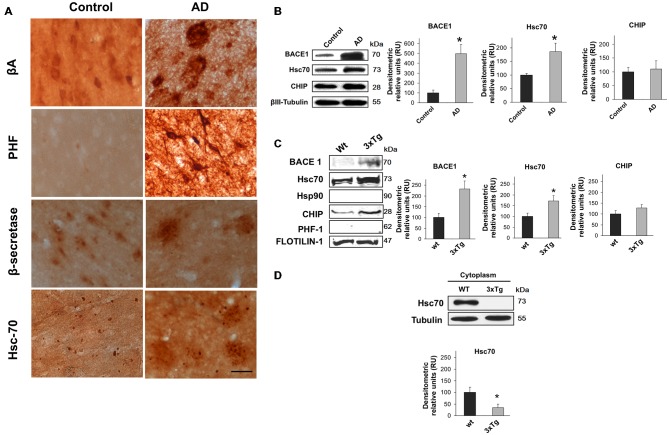
BACE1 and Hsc70 in AD-affected human brains and in lipid rafts from triple-transgenic Alzheimer’s disease mouse brains. (A) β-amyloid, PHF-1, BACE1 and Hsc70 immunoreactivity in the temporal gyrus of AD-affected brains (AD) and control brains. 40× magnification; scale bar: 20 μm. n = 4. (B) BACE1, Hsc70 and CHIP Western blotting from the temporal gyrus of AD brains (AD); normal human brains were used as controls. A representative plot is shown. βIII-tubulin was used as a loading control. Densitometric quantification was performed; RU = relative units. n = 4, *p < 0.05. (C) Western blotting of BACE1, Hsc70, Hsp90, CHIP and PHF-1 proteins in lipid rafts isolated from the cerebral cortex of 15-month-old wild-type and 3xTg-AD mice. Flotillin-1 was used as a loading control. Densitometric quantification was performed; RU = relative units. n = 3, *p < 0.05. (D) Western blotting of Hsc70 in the cytoplasmic fraction from the cerebral cortex of wild-type and 3xTg-AD mice. RU = relative units. n = 3, *p < 0.05. Representative blots are shown. The arrow shows the band corresponding to the expected molecular weight of the BACE1 protein.